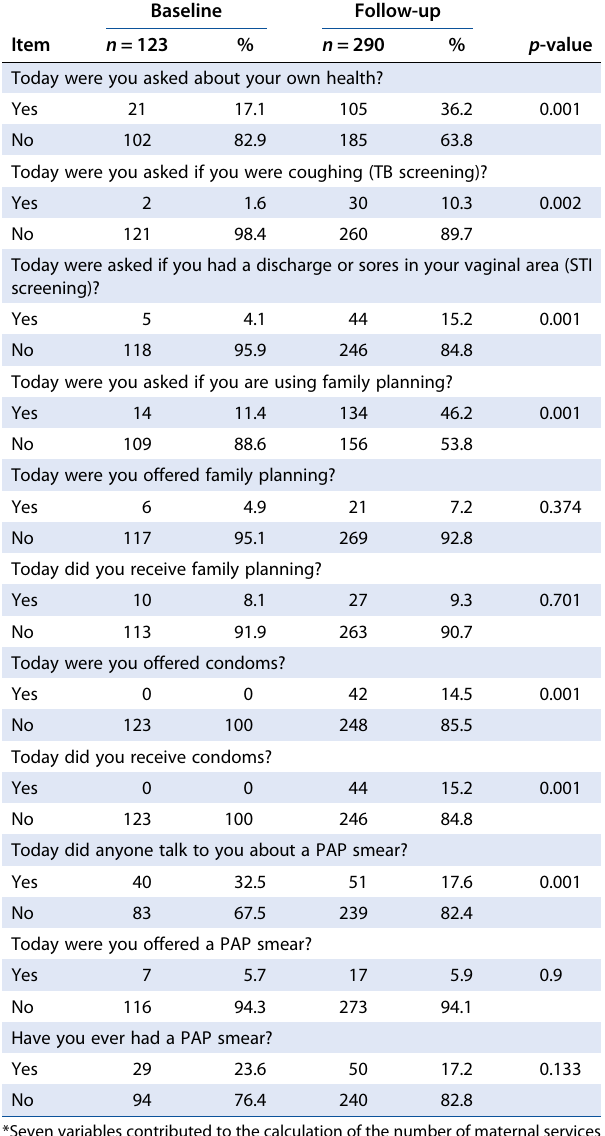
Table 2: Maternal services discussed and received Baseline Item